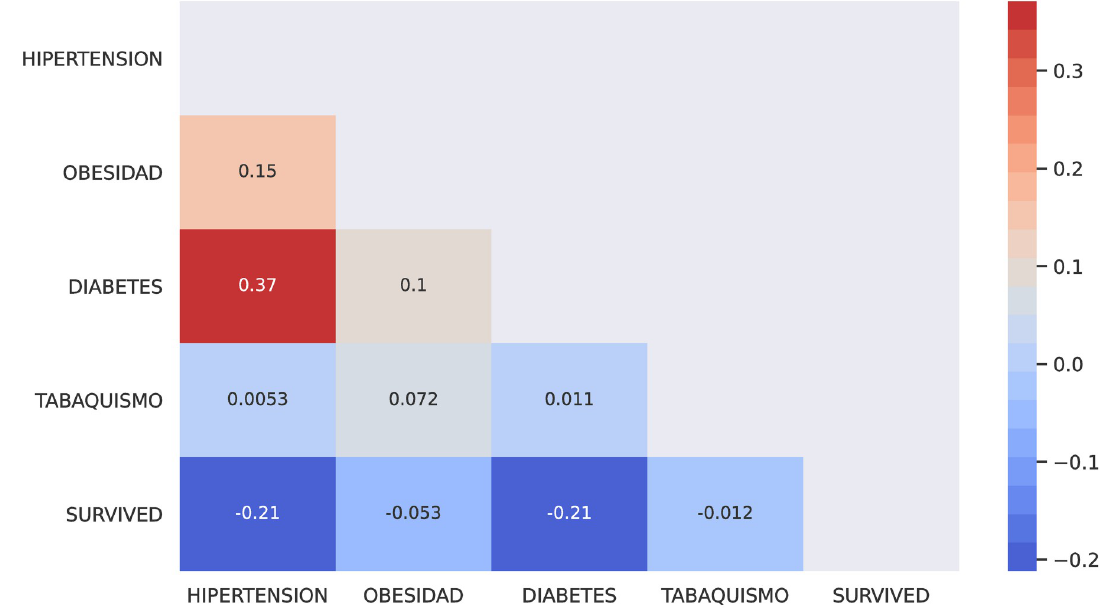
Fig 7. Covariance matrix of the most relevant chronic diseases with respect to the survival chance of a hospitalized patient in Mexico.